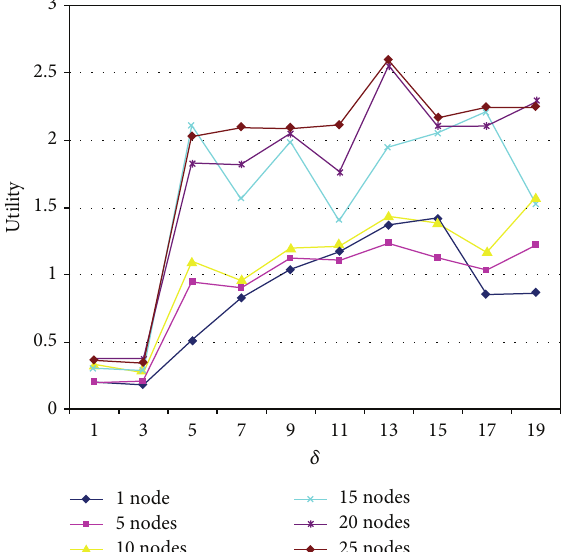
Figure 10: Correlation between delta and utility.